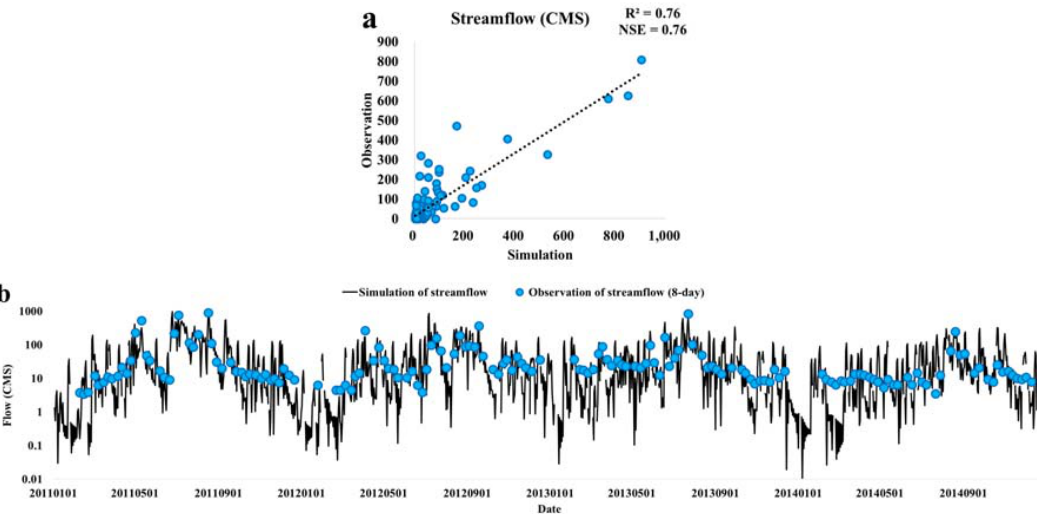
watershed (2011–2014). Water 2016 , 8 , 292